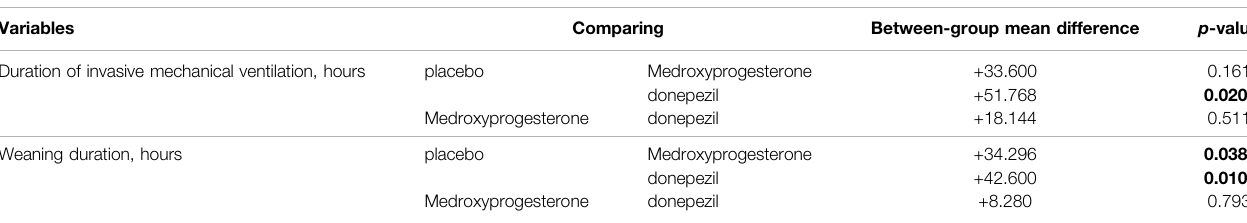
TABLE 2 | Trends of changes in primary